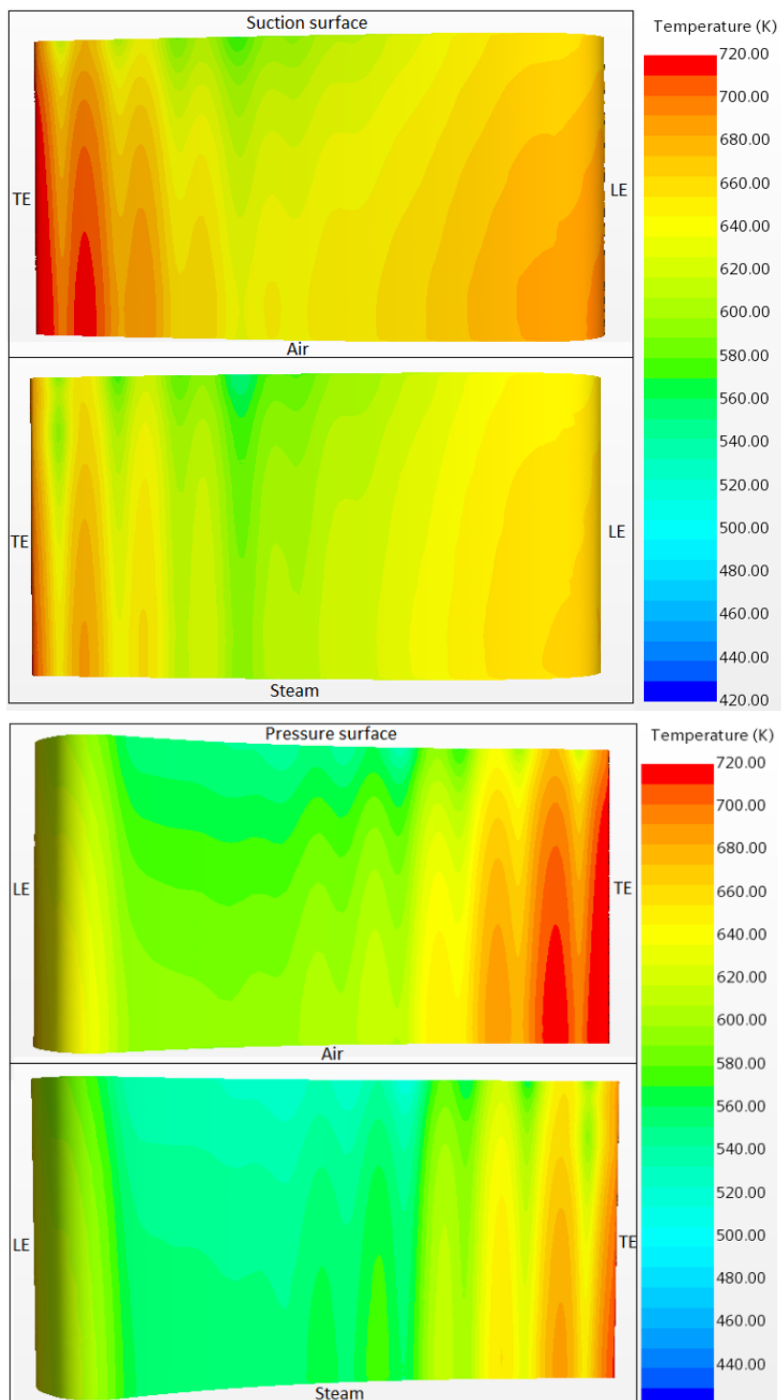
Figure 11. Temperature contour comparison at the pressure and suction